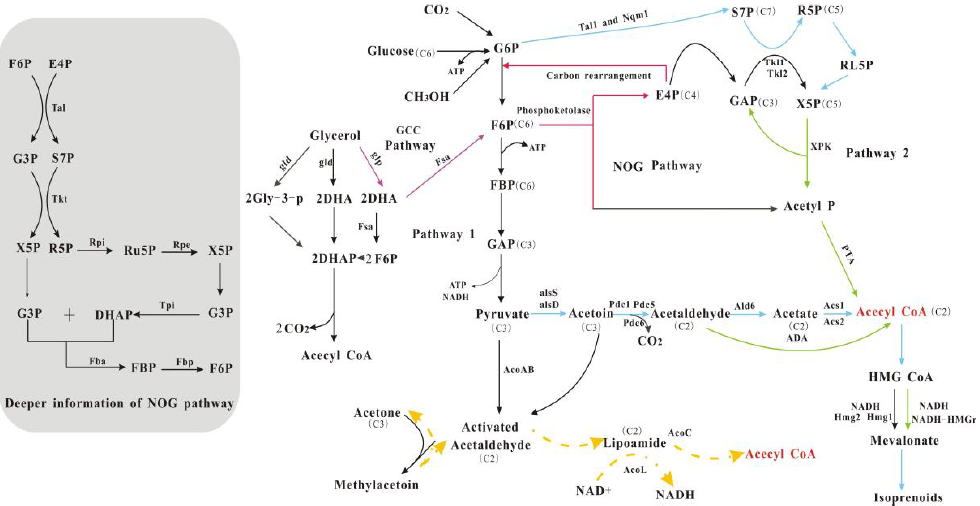
Figure 2. Rewired carbon pathways with improved carbon economy. G6P: 6-P-glucose; F6P: fructose-6-phosphate; FBP: fructose 1,6-bisphosphatase; E4P: erythorse 4-phosphate; G3P: glyceraldehyde 3-phosphate; X5P: xylulose 5-phosphate; R5P: ribose 5-phosphate; Ru5P: ribulose